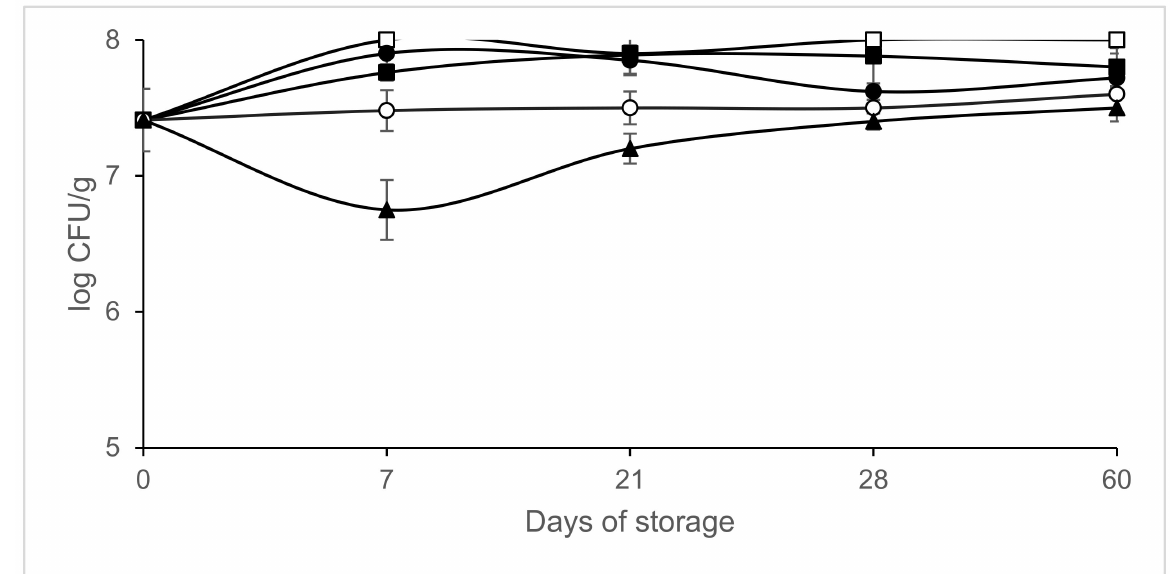
Figure 2. Effect of packaging conditions on mesophile counts in inoculated sliced chorizo packaged in modified atmospheres. Packaging conditions: Air ( (cid:3) ), 100% Nitrogen ( (cid:4) ), Vacuum ( • ), 20% CO 2 /80%N 2 (